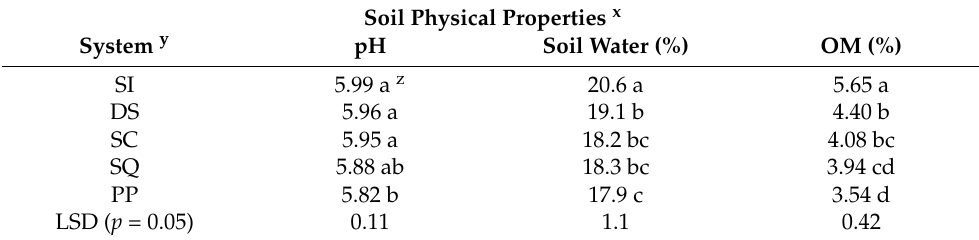
Table 6. Effect of different cropping systems on soil physical properties soil pH, soil water content, and organic matter content (OM) measured in the spring of each year over three cropping seasons